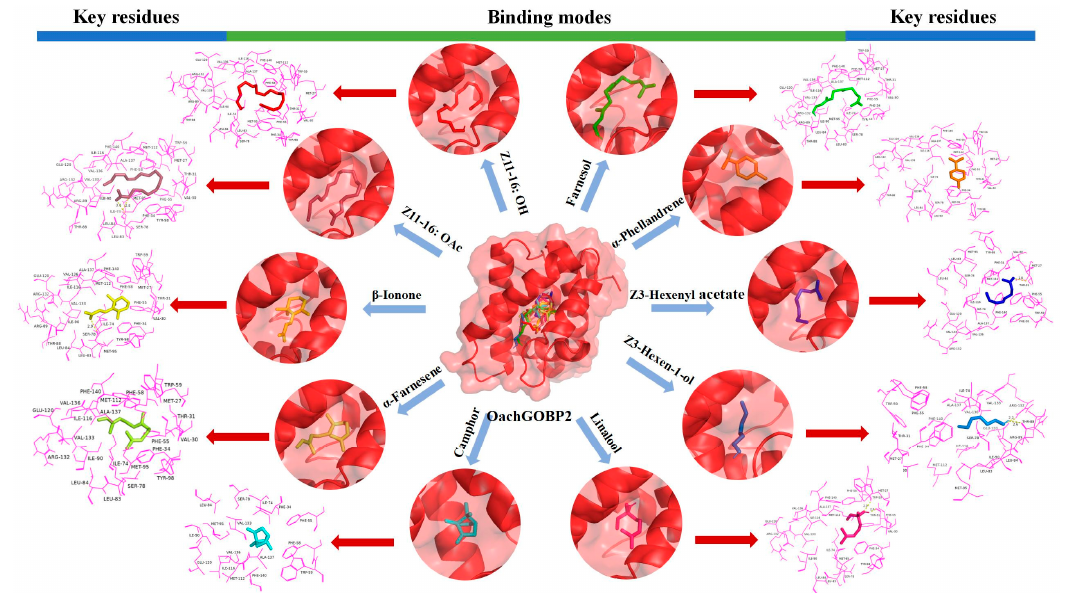
Figure 7. Binding modes and key residues of OachGOBP2 with different ligands: Farnesol (green), α -Phellandrene (orange), Z3-Hexenyl acetate (blue), Z3-Hexen-1-ol (marine), Linalool (hot), Camphor (cyan), α -Farnesene (limon), β -Ionone (yellow), Z 11-16: OAc (raspberry) and Z 11-16: OH (red) in the putative binding pocket of chain A of OachGOBP2. The key residues of the different ligands that interact with OachGOBP2. The residues within 4Å of the ligands are highlighted in magenta. (For interpretation of the references to color in this figure legend, the reader is referred to the web version of this article.)